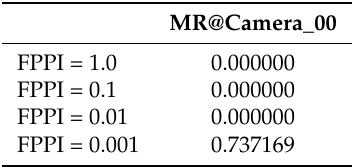
Table 11. Accuracy table @ Camera_00, informed-filters, some viewpoints.